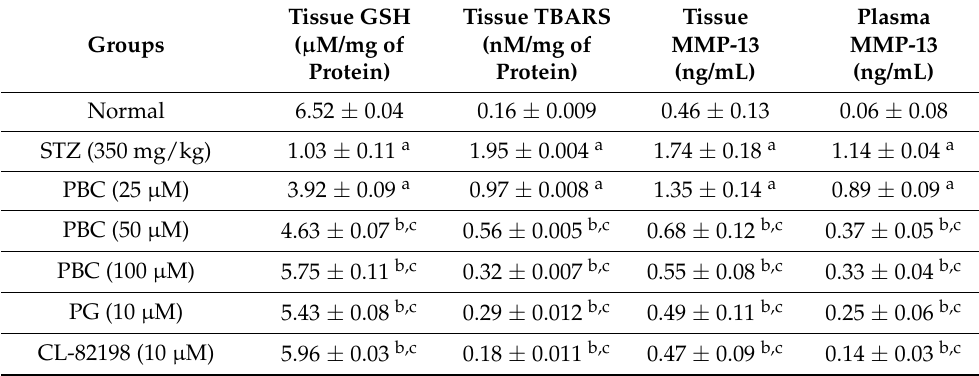
Table 2. Effect of PBC in STZ-induced biomarker